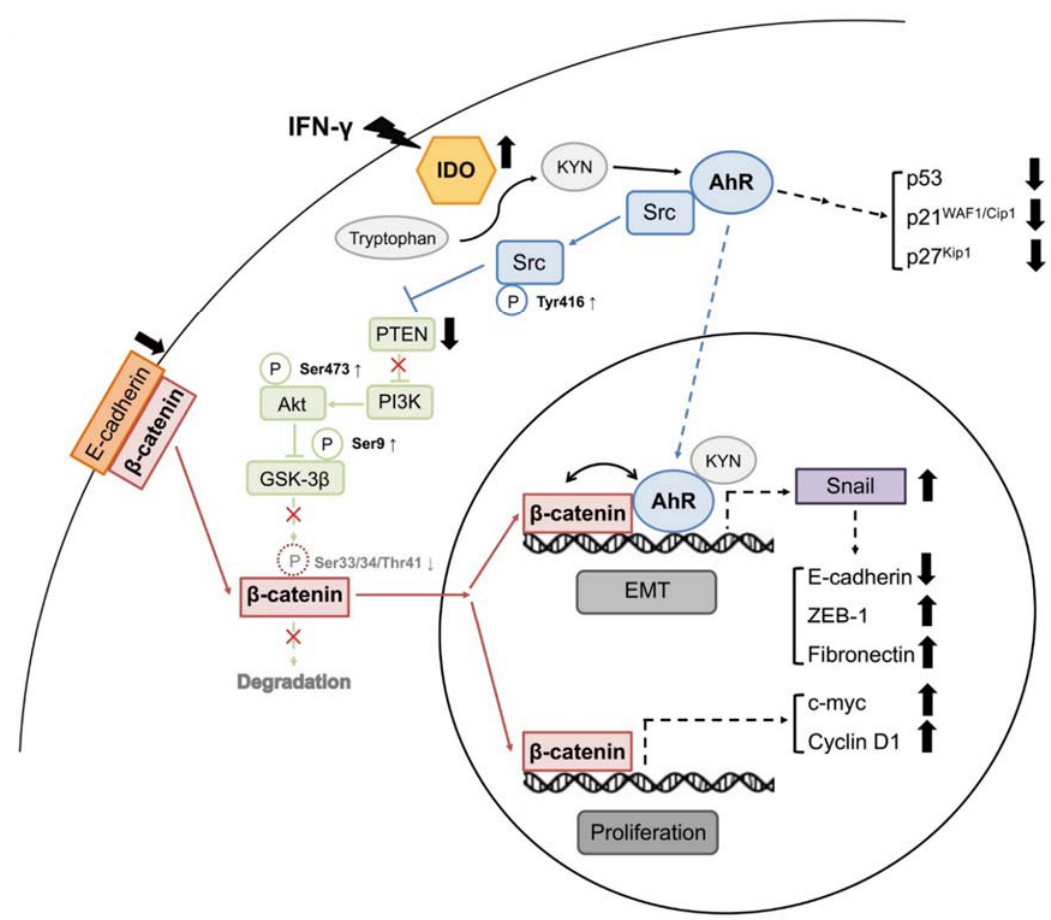
Figure 6. A proposed model of IDO1-induced HCC progression via coordinated promotion of AhR and β -catenin pathways. Activation of IDO1 in HCC promotes activity of the downstream mediator AhR. Activated AhR subsequently upregulates Snail and promotes β -catenin activity through Src-mediated Akt activation and GSK-3 β inhibition. Alone or together, IDO1 activity-induced AhR and β -catenin modulate the expression of Snail-regulated EMT molecules, proliferative markers, and cell cycle checkpoint inhibitors, though with cell diversity, to promote proliferation and facilitate metastasis of HCC cells. Dash line stands for versatile